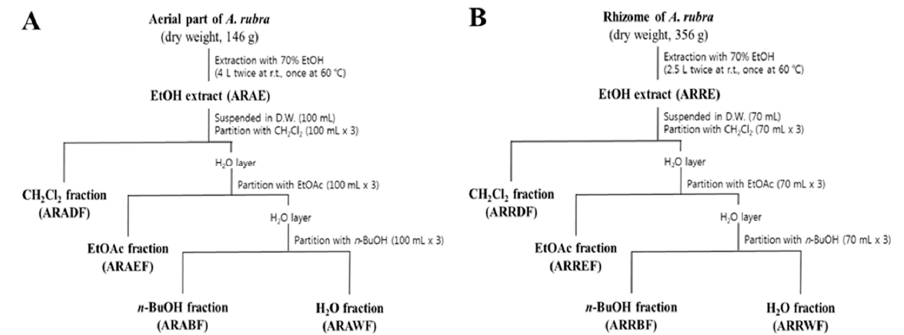
Figure 2. Extraction and fractionation scheme for Astilbe rubra . ( A ) Extraction and fractionation of the aerial part. ( B ) Extraction and fractionation of the rhizome. The dried samples were subjected to extraction separately with 70% ethanol. The extracts of the aerial parts and rhizome (ARAE and ARRE, respectively) were consecutively partitioned with dichloromethane (CH 2 Cl 2 ), ethyl acetate (EtOAc), and butanol (n-BuOH) to give four solvent fractions.